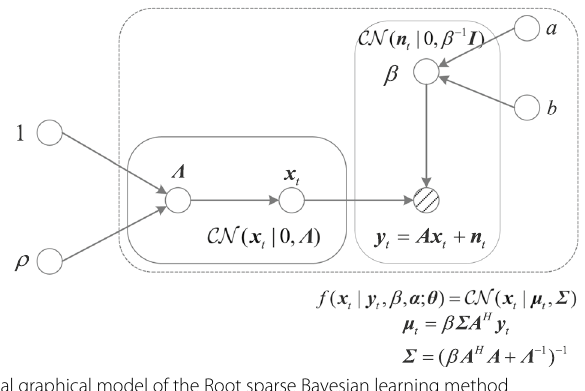
Fig. 2 Hierarchical graphical model of the Root sparse Bayesian learning